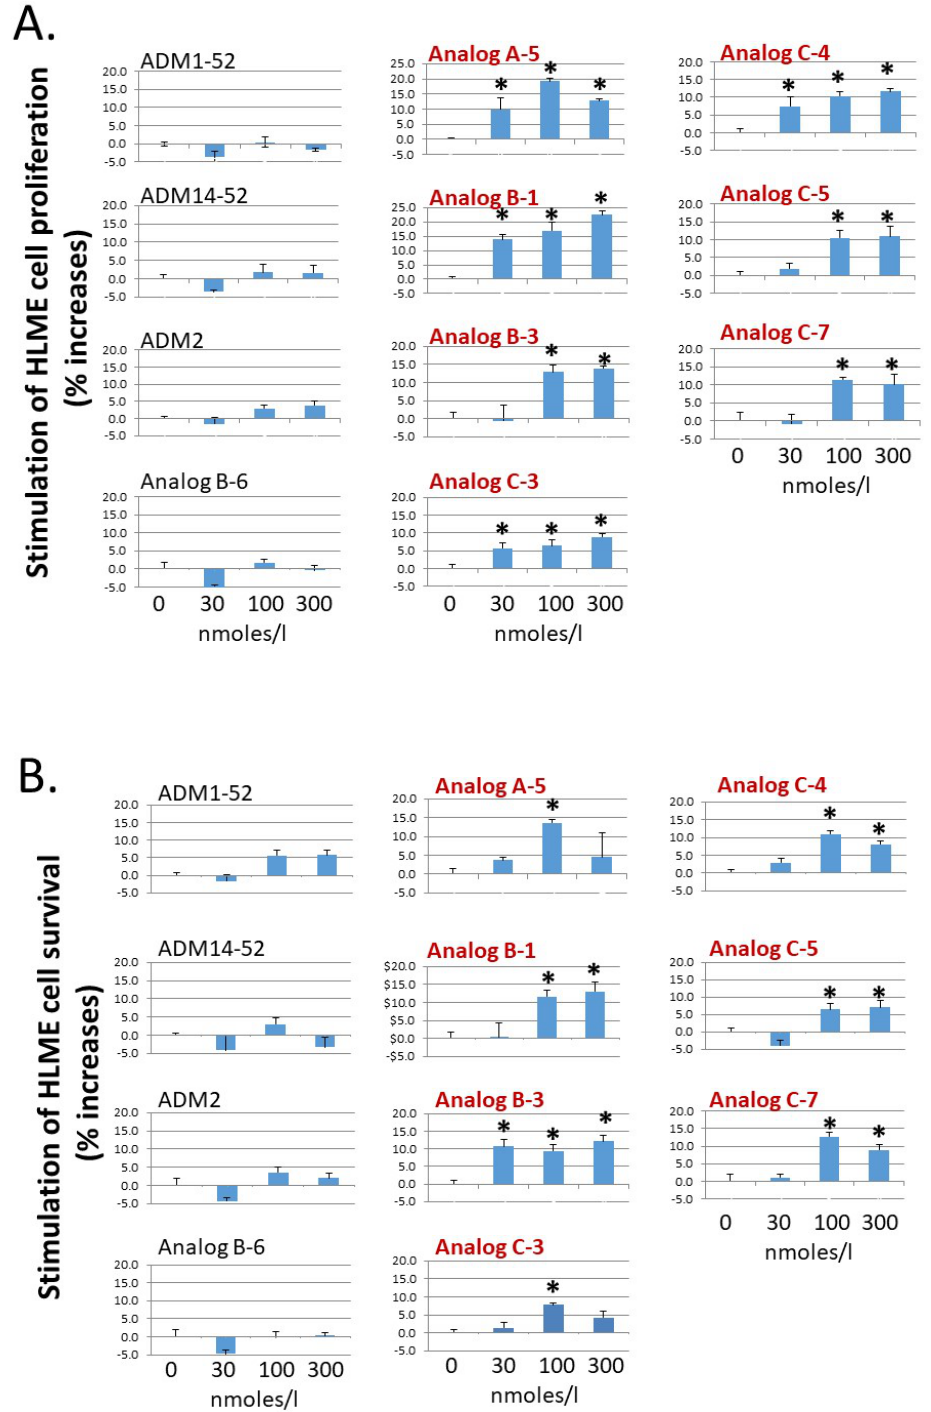
Figure 3. Analogs with enhanced receptor-activation activity potently stimulate the proliferation and survival of primary HLME cells. Analogs A-5, B-1, B-3, C-3, C-4, C-5, and C-7 significantly increased ( A ) the proliferation of primary human lymphatic microvascular endothelial (HLME) cells in a medium with 2% FBS and ( B ) the survival of HLME cells in medium with 0.1% FBS. HLME cells were cultured for 72 h, and cell viability was quantified with the MTT assay. The wild-type peptides (ADM1-52, ADM14-52, and ADM2) and a nonlipidated analog (Analog B-6) had negligible effects on HLME cell proliferation and survival. Analogs with an enhanced CLR/RAMP2-activation activity are indicated by red letters. Data are mean ± SEM of quintuplicate samples. Similar results were obtained in at least three different experiments. *, Significantly different from